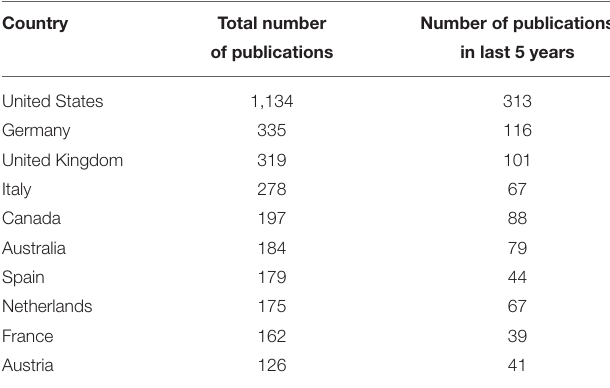
TABLE 1 | Ten most productive countries.